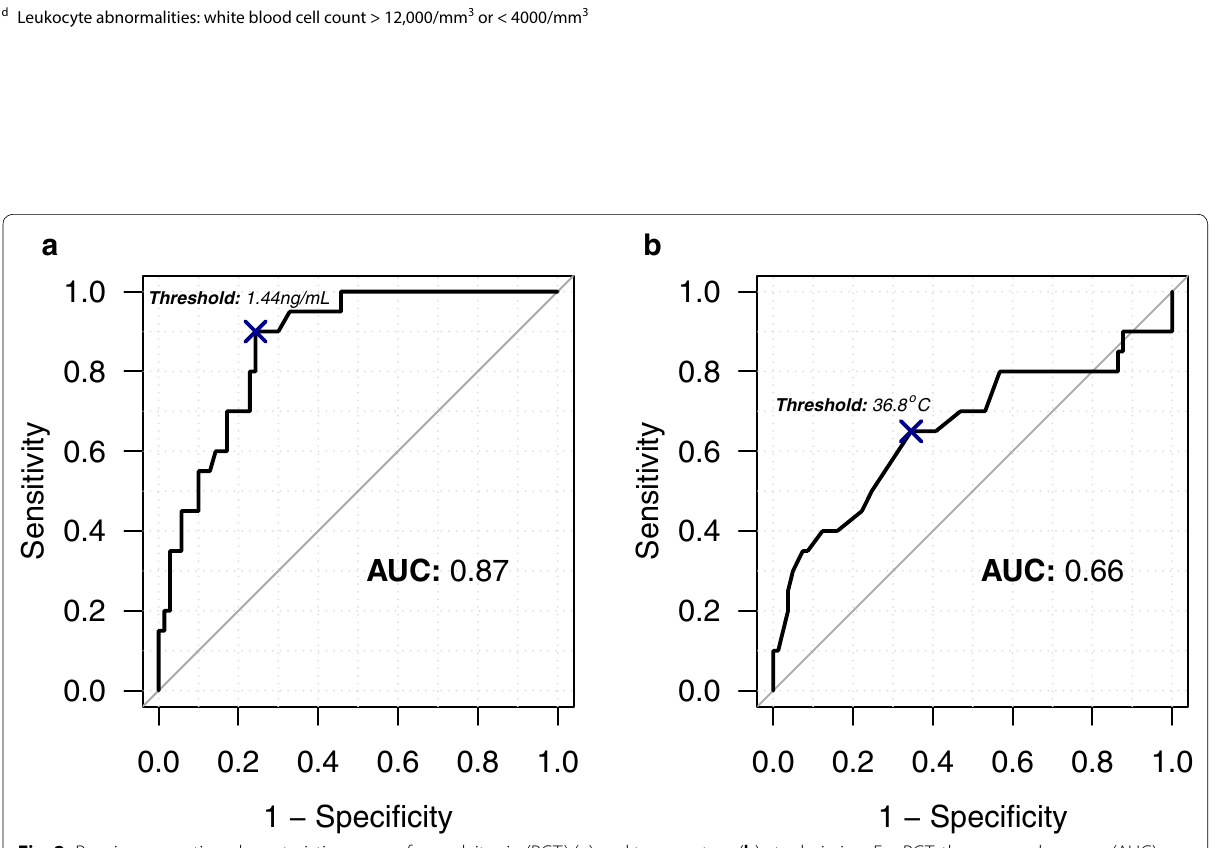
Fig. 2 Receiver operating characteristics curve of procalcitonin (PCT) ( a ) and temperature ( b ) at admission. For PCT, the area under curve (AUC) was 0.87 with optimal cutoff at 1.44 ng/mL leading to a sensitivity and specificity of 0.90 (IC95 [0.75–1.00]) and 0.76 (IC95 [0.66–0.84]), respectively. Positive and negative likelihood ratios were 3.75 and 0.13, respectively. For temperature, the area under curve (AUC) was 0.66 with optimal cutoff at 36.8 °C leading to a sensitivity and specificity of 0.65 (IC95 [0.45–0.85]) and 0.65 (IC95 [0.56–0.75]), respectively. Positive and negative likelihood ratios were 1.86 and 0.54,